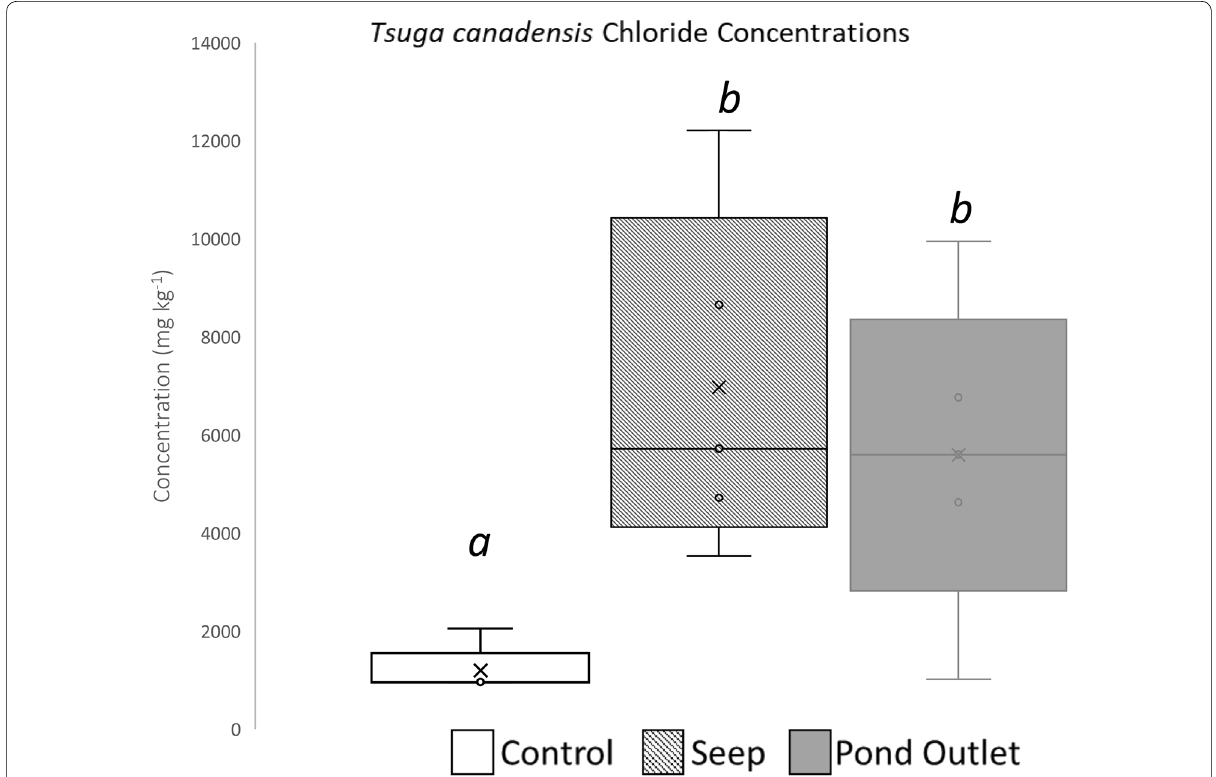
Fig. 5 Chloride concentrations in Tsuga canadensis needle and twig samples. Different letters denote statistically significant